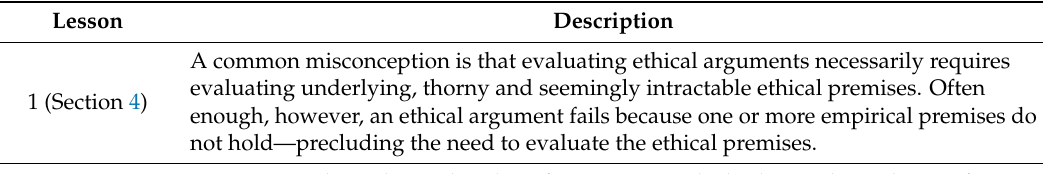
Table 1. The analysis developed here—while motivated by an interest to evaluate the appropriateness of lion farming—leads to the identification of general lessons of value to any ethical